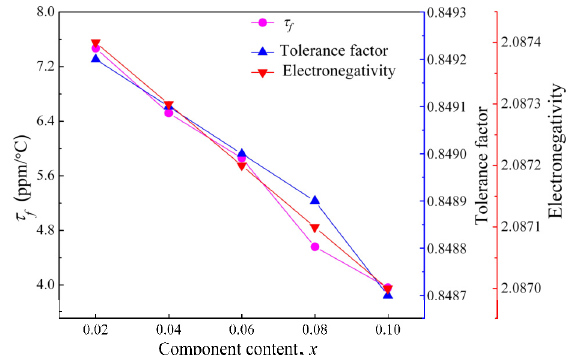
Fig. 8 Variation of the temperature coefficient of resonant frequency (  ), electronegativity ( e ), and tolerance factor f ( t ) of the (Ba 1 − x Sr x ) 4 (Sm 0.4 Nd 0.6 ) 28/3 Ti 18 O 54 ceramics with different x values sintered at 1440 ℃ for 4